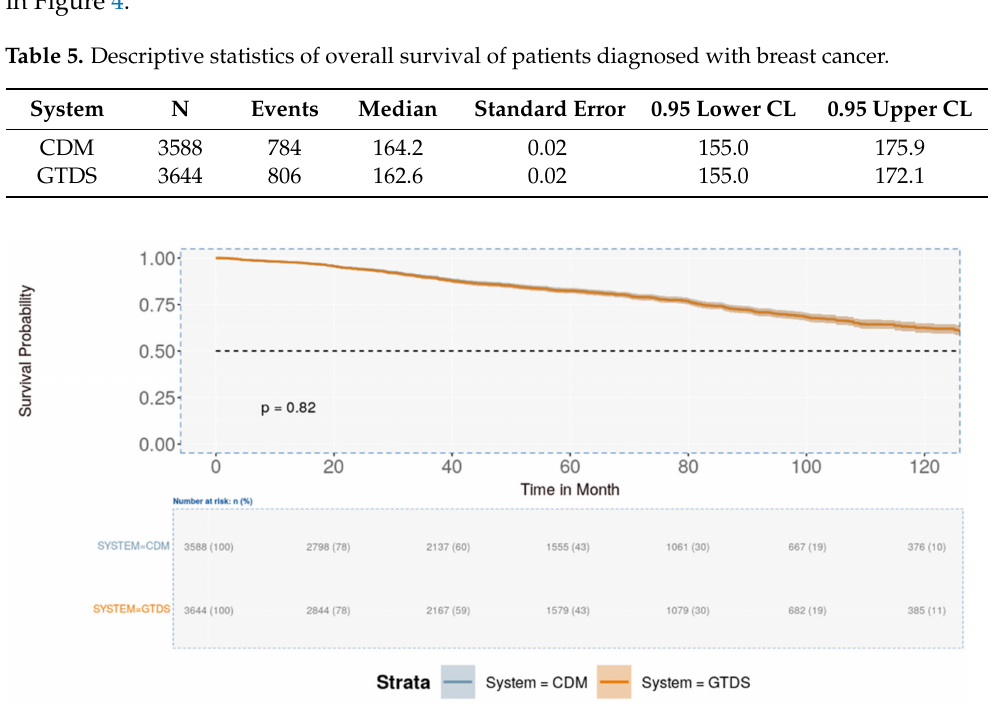
Figure 4. Comparison of overall survival of a breast cancer cohort between CDM and source